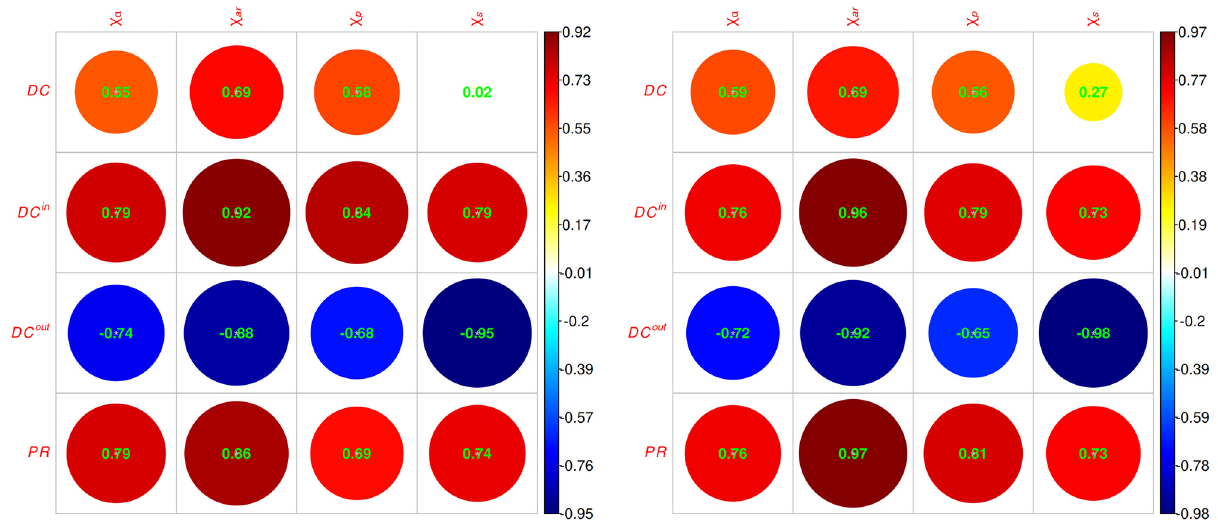
Figure 9: Pearson correlation analysis in the four DCBNs. Figure 10: Spearman correlation analysis in the four